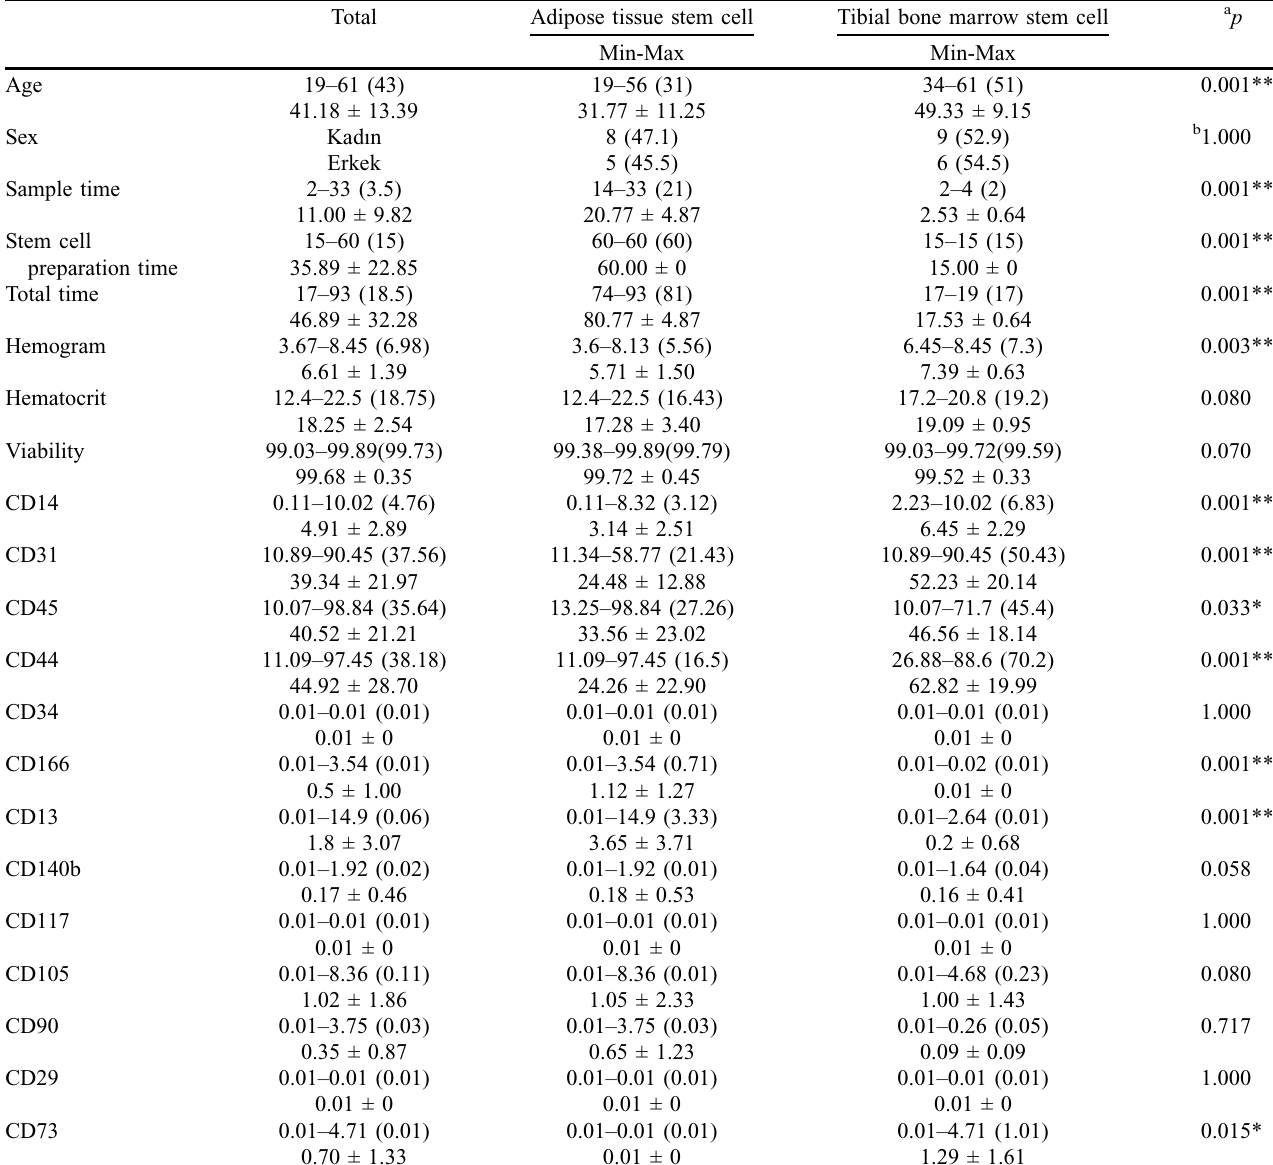
Table 1. Comparison of stem cell values derived from adipose tissue and tibial bone